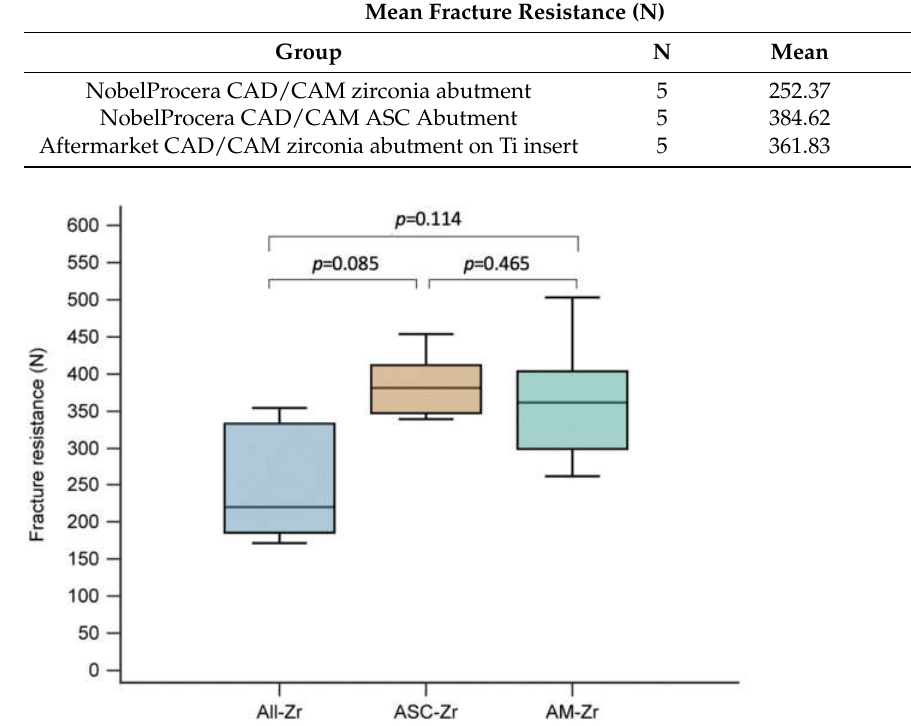
Figure 5. Box plot showing the fracture resistance of ASC-Zr abutments was marginally higher than All-Zr abutments ( p = 0.085), followed by group-to-group comparisons.